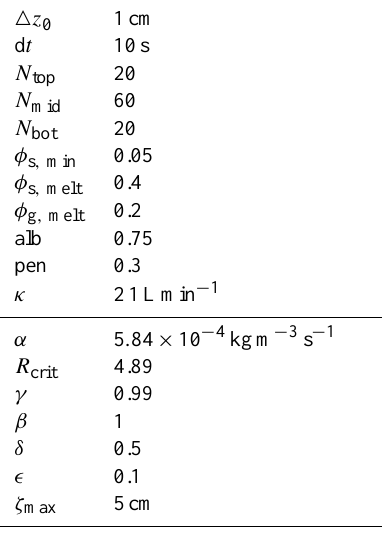
Table 1. Default model settings and free parameter values of salinity